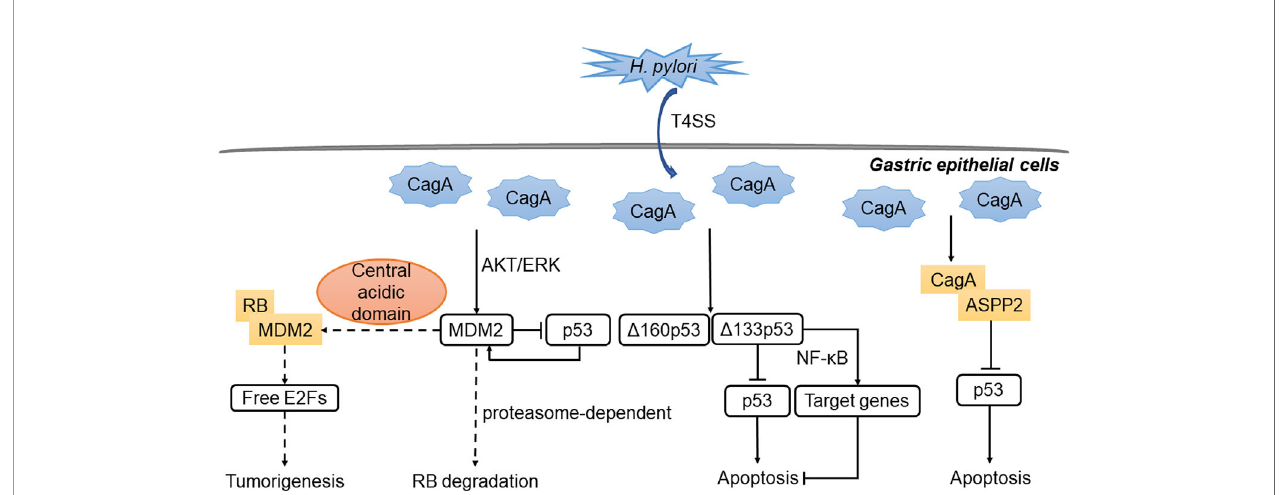
FIGURE 3 | Regulation of p53 and RB by H. pylori in stomach. The virulence factor CagA is introduced into gastric epithelial cells by T4SS. CagA binds to ASPP2, thereby inhibiting the binding of ASPP2 to p53, leading to decreased apoptosis. Besides, MDM2 is activated through the AKT/ERK pathway and form a negative feedback loop with p53. MDM2 can bind to RB and inhibits the function of RB-E2F repressor. Meanwhile, the expression of the isoforms of p53 inhibits the activity of p53 or activates NF- k B target genes. The outcome is the down-regulation of apoptosis and the occurrence of gastric